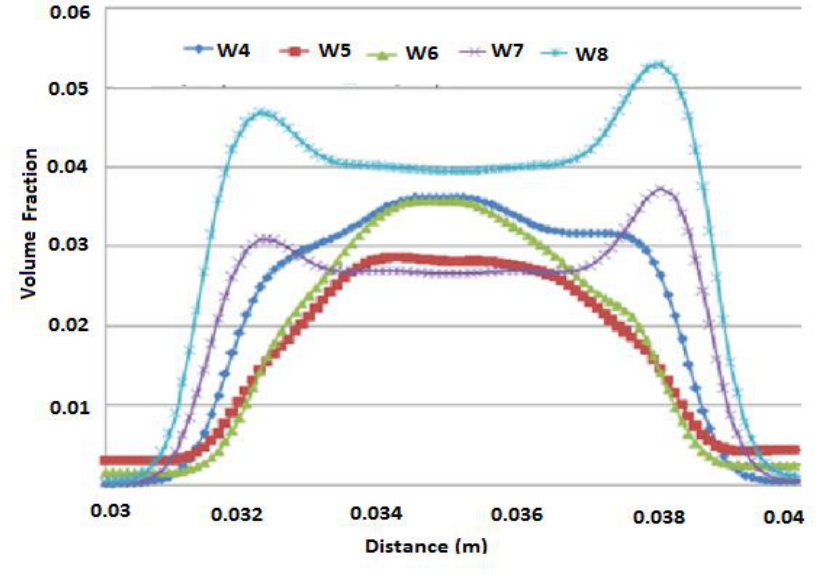
Figure 7. Variation of solid phase volume fraction for particle sizes along plane